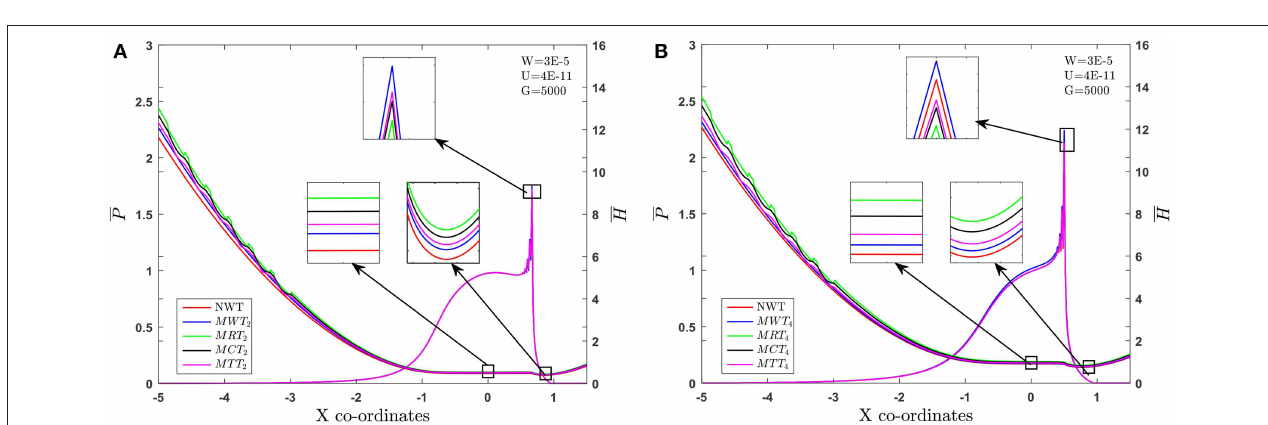
Frontiers in Mechanical Engineering |